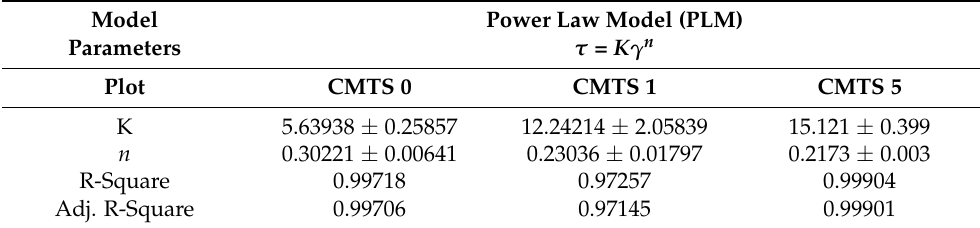
Table 4. Rheological Modeling Parameters.